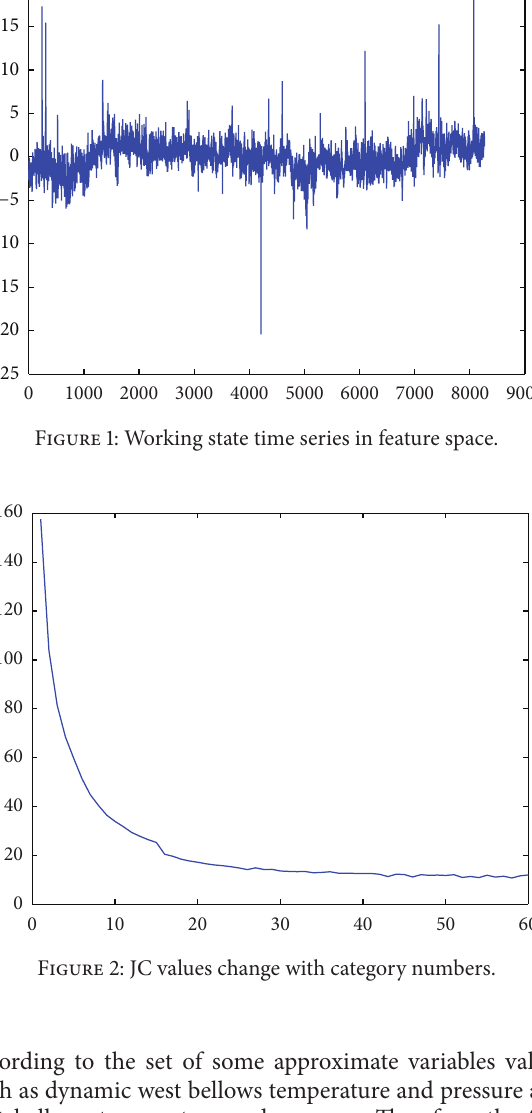
Table 1: The partial data in parameter space.